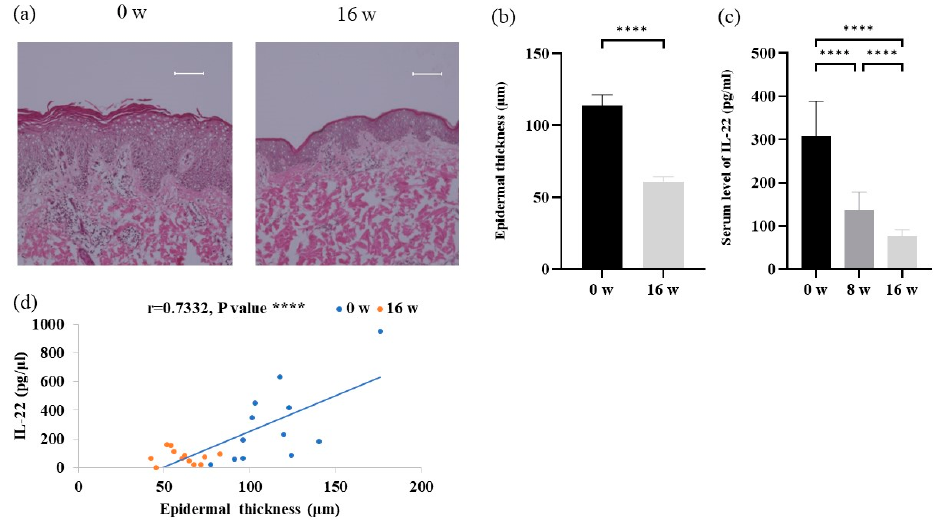
Figure 3. Analysis of epidermal thickness and IL-22 in atopic dermatitis patients before and after the dupilumab treatment. ( a ) Skin sections stained with H&E. Scale bars = 100 μ m. ( b ) Epidermal thickness. ( c ) Serum levels of IL-22. ( d ) Correlation analysis between serum IL-22 levels and epidermal thickness. Data are shown as the mean ± standard error of the mean (n = 12 per group). Coefficients (r) were assessed by Spearman’s rank correlation test. Statistical analyses were performed with Šidák’s multiple comparison test. **** p < 0.0001. IL, interleukin.